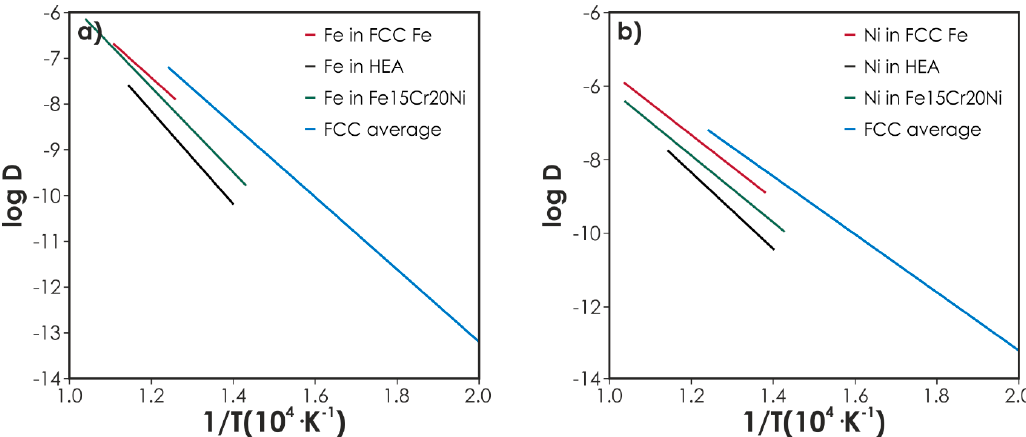
Figure 29. Normalized diffusion data (Equation (20)) vs. reciprocal reduced temperature for ( a ) Fe and Fe alloys, ( b ) Ni and Ni alloys (after [48]). Reprinted from Materials Letters (2016), On the diffusion in high-entropy alloys, 193–207, Copyright 2016, with permission from Elsevier.